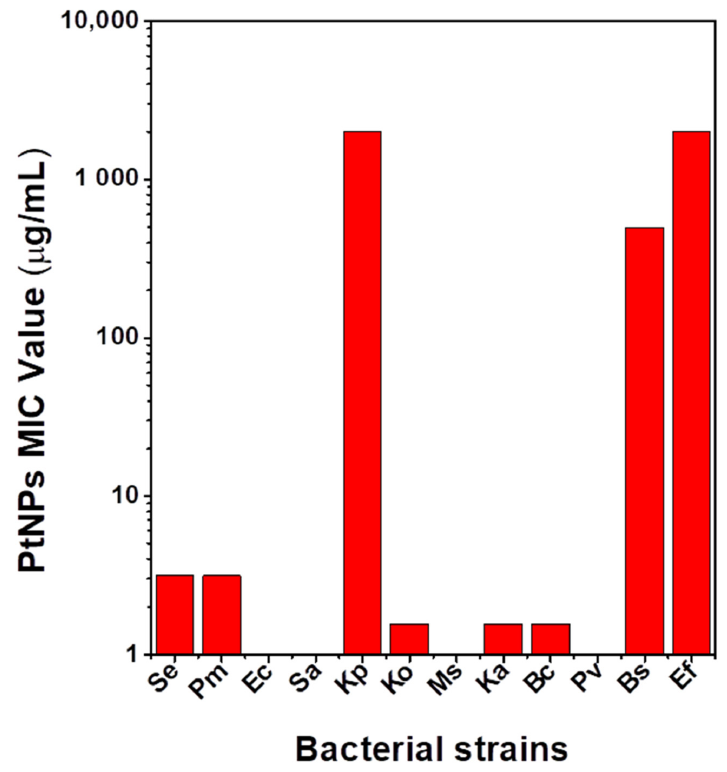
Figure 6. MIC values of